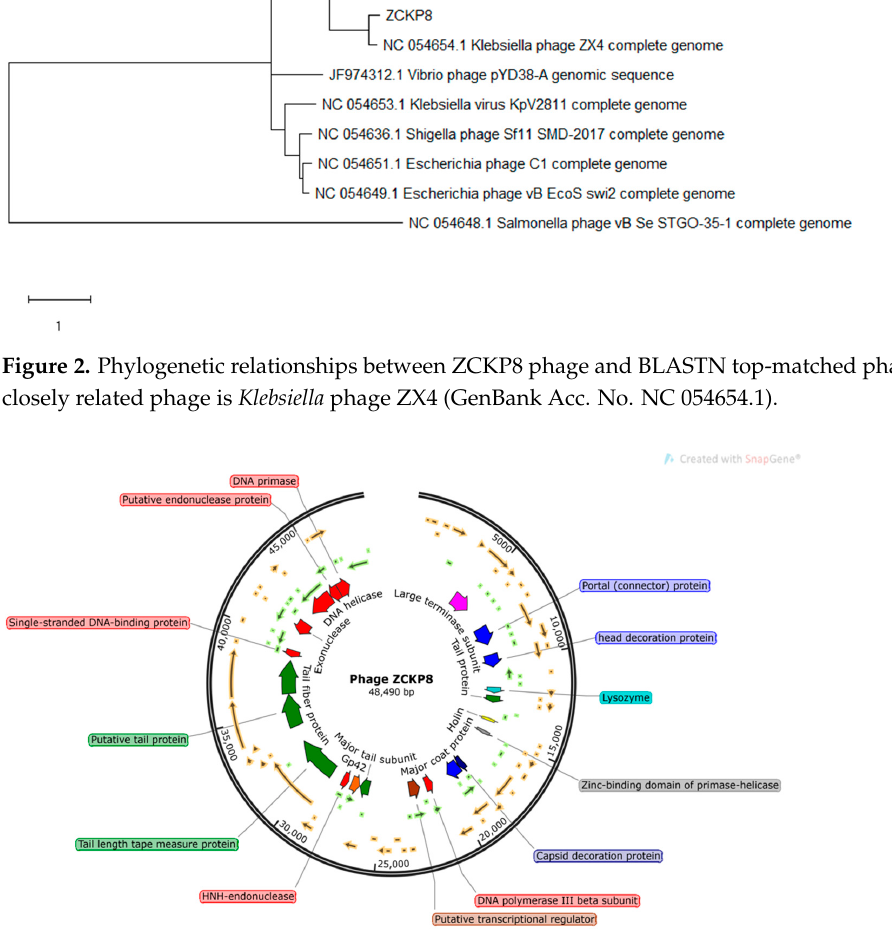
Figure 3. The ZCKP8 genome map. Only CDSs with known functions are labeled in their positions. Those representing hypothetical proteins are not labeled.